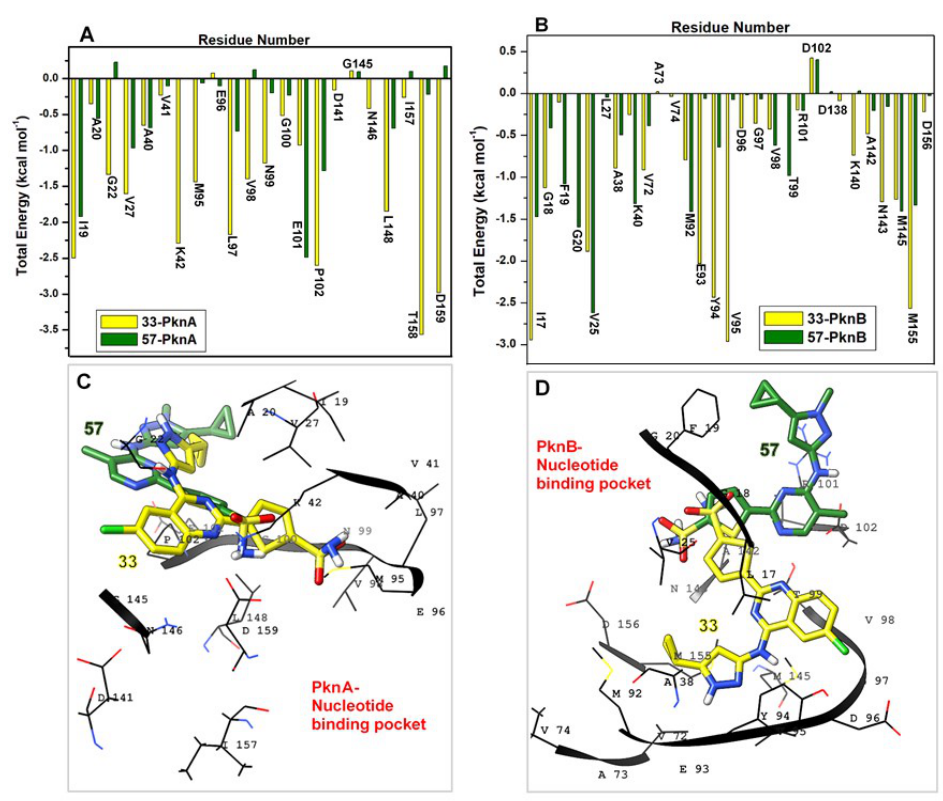
Figure 11. Total energy contributions of important catalytic residues to the differential binding and stabilities of compounds 33 and 57 at the nucleotide binding pockets of PknA and PknB. ( A ) Comparative energies of catalytic residues to 33 and 57 in PknA ( B ) Comparative energies of catalytic residues to 33 and 57 in PknB ( C ) Structural representation showing the positioning of 33 and 57 relative to the NBP residues in PknA ( D ) Structural representation showing the positioning of 33 and 57 relative to the NBP residues in PknB.